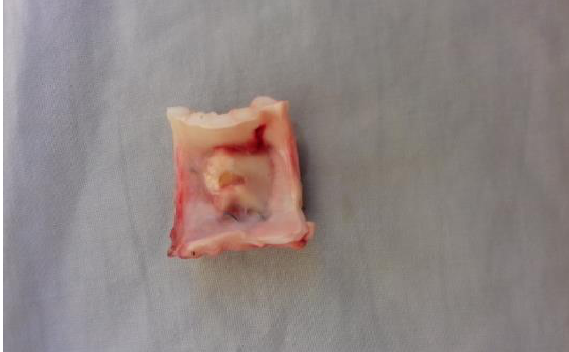
Figure, 11: Shows disappearance tracheal defect of dog relatively at 60 postoperative day in